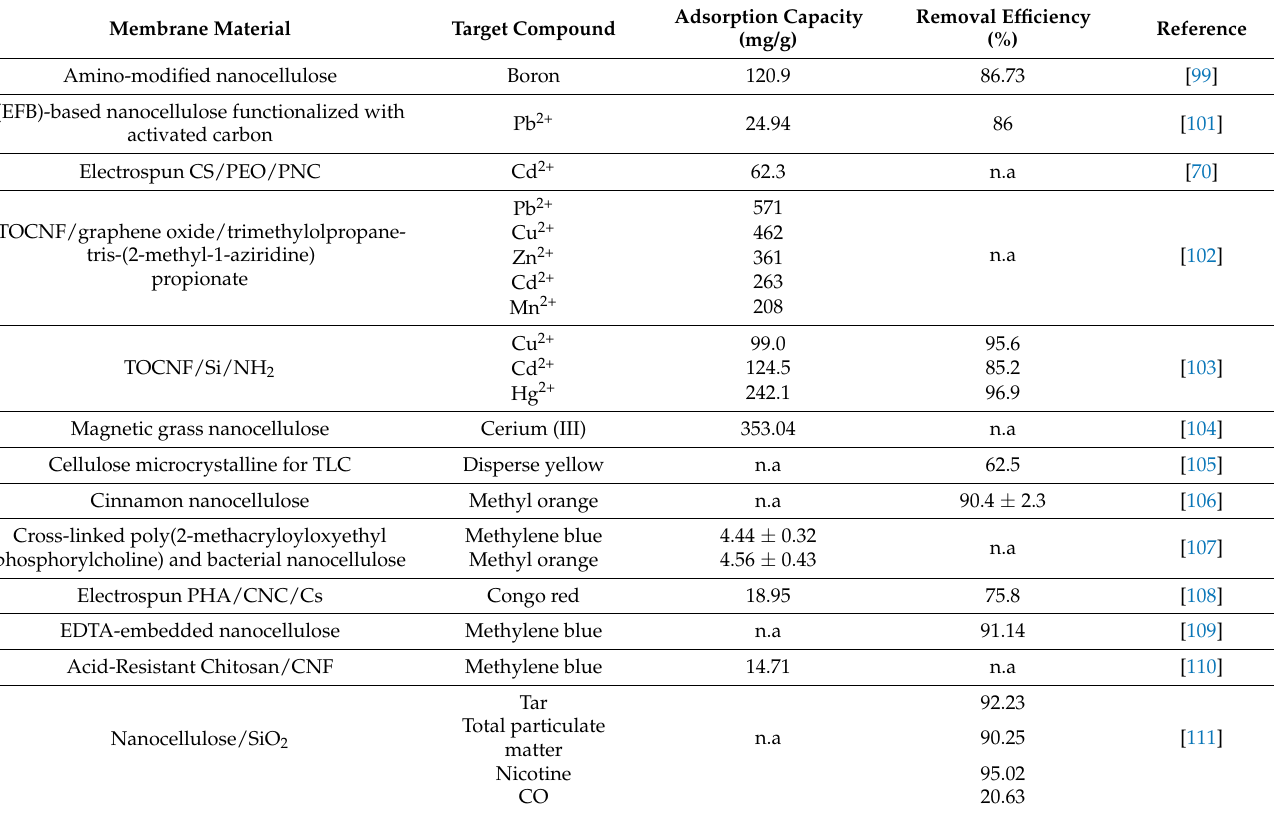
Table 4. Nanocellulose-based adsorbents for the removal of specific